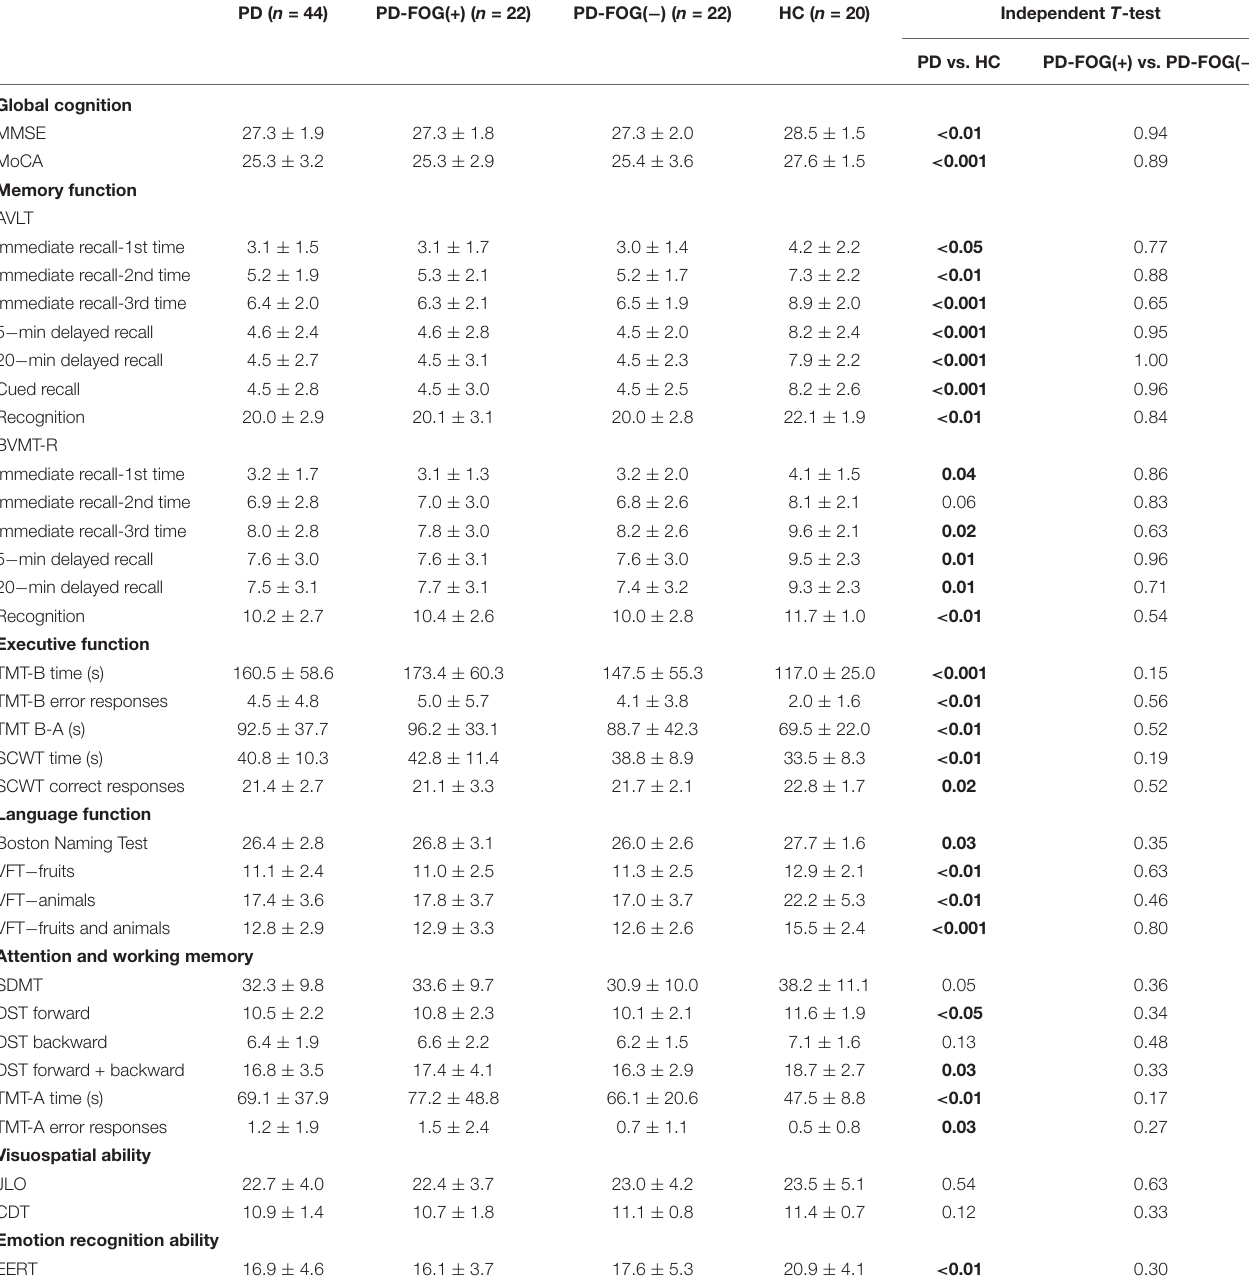
TABLE 2 | Neuropsychological assessment of PD, PD-FOG(+), PD-FOG( − ) patients, and HC. PD ( n = 44) PD-FOG(+) ( n = 22) PD-FOG( − ) ( n = 22) HC ( n = 20) Independent T -test